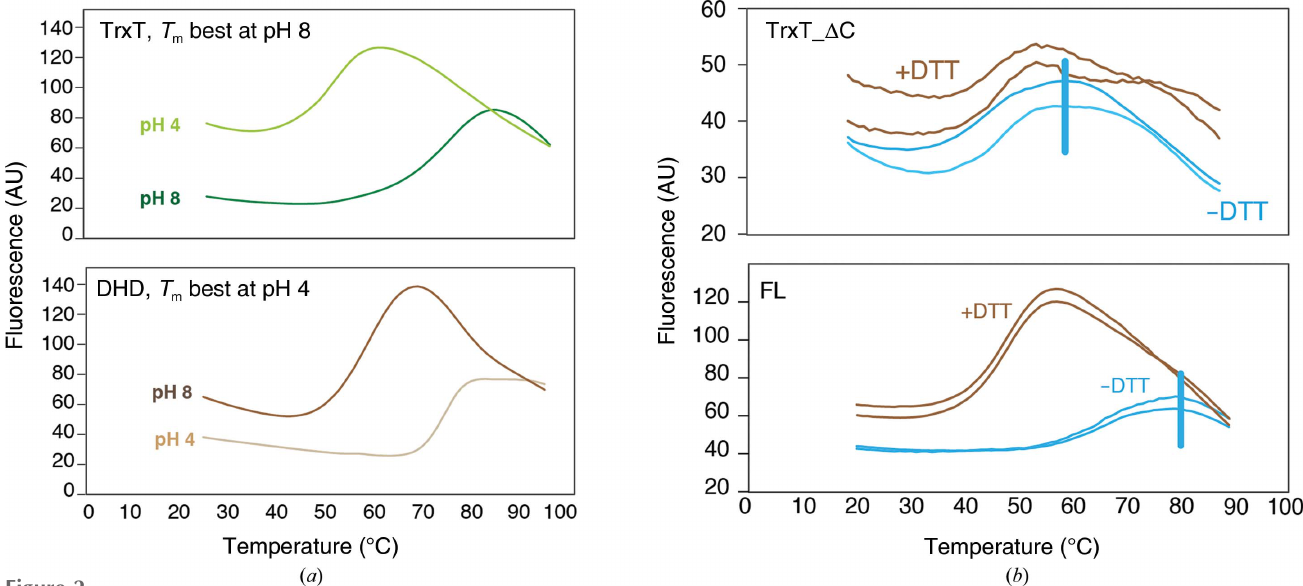
Figure 2 Stability and flexibility of TrxTand Dhd. ( a ) Thermal shift assay of TrxTand Dhd after incubation of natively folded proteins with SYPRO Orange dye in a 96-well PCR plate at two different pH values. As the proteins unfold with temperature, the SYPRO Orange fluorescence emission increases. TrxT is thermally stable with a T m of >70 (cid:4) C in alkaline buffers, whereas acidic buffers are necessary for Dhd to reach the same stability. Values were obtained in triplicate and were collected under different conditions (Supplementary Table S2). ( b ) Thermal stability of full-length (FL) TrxT and TrxT_ (cid:2) C constructs in the presence or absence of DTT (duplicates). FL TrxT is (cid:6) 20 (cid:4) C more stable than the protein